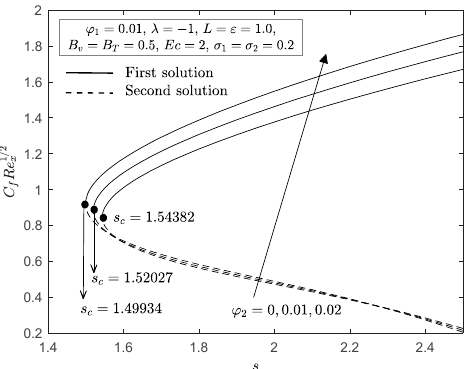
Figure 2. C f Re 1/2 x with s for various ϕ 2 .